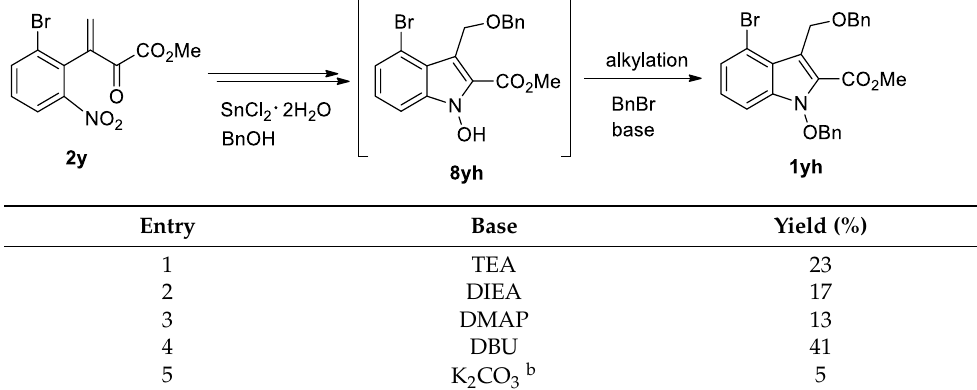
Table 1. Synthesis of 1-alkoxyindole 1yh in different base conditions a .